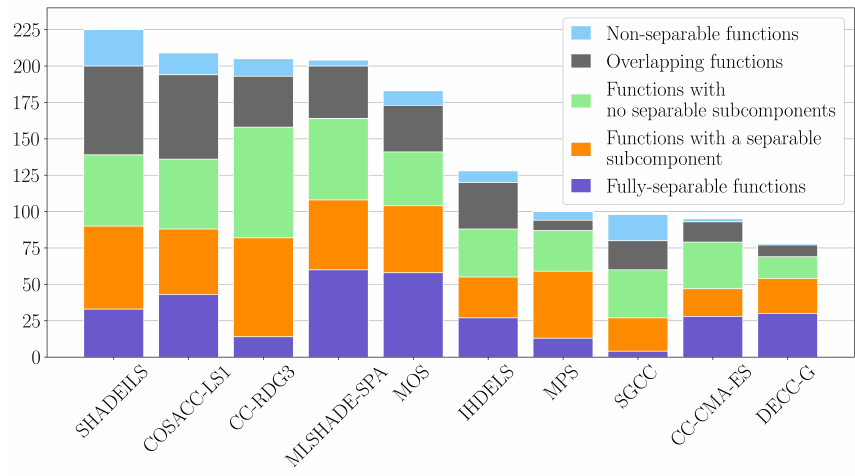
Figure 3. Summary scores of state-of-the-art algorithms.